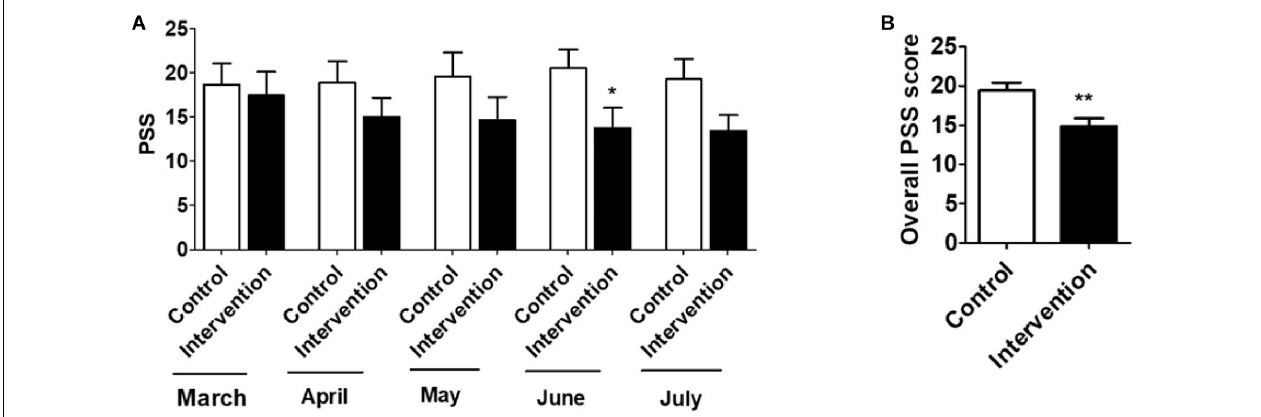
FIGURE 1 | (A) Mean ± SD of Perceived Stress Score (PSS) of control ( n = 10) and Intervention ( n = 9) groups for March to July. (B) Mean ± SD of overall PSS of control ( n = 50, 10 subjects for 5 months) and intervention ( n = 45, 9 subjects for 5 months) groups. T -test was applied to compare the scores between intervention and control groups. p < 0.05, p < 0.01 are represented as “*” and “**”, respectively when compared the scores between intervention and control groups. “#” represents p < 0.05 when compared between intervention groups (March vs. other months). “$” represents p < 0.05 when compared between control groups (March vs. other